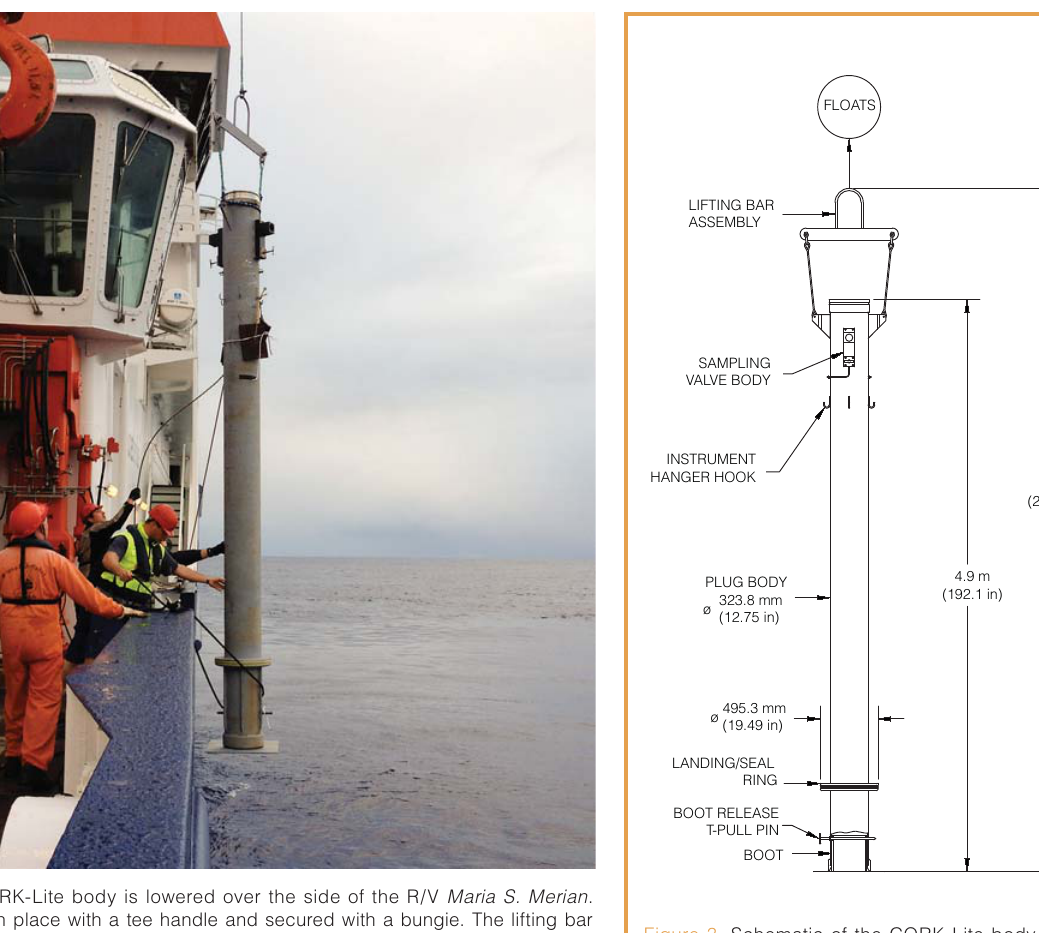
Figure 3. Schematic of the CORK-Lite body during free fall to the